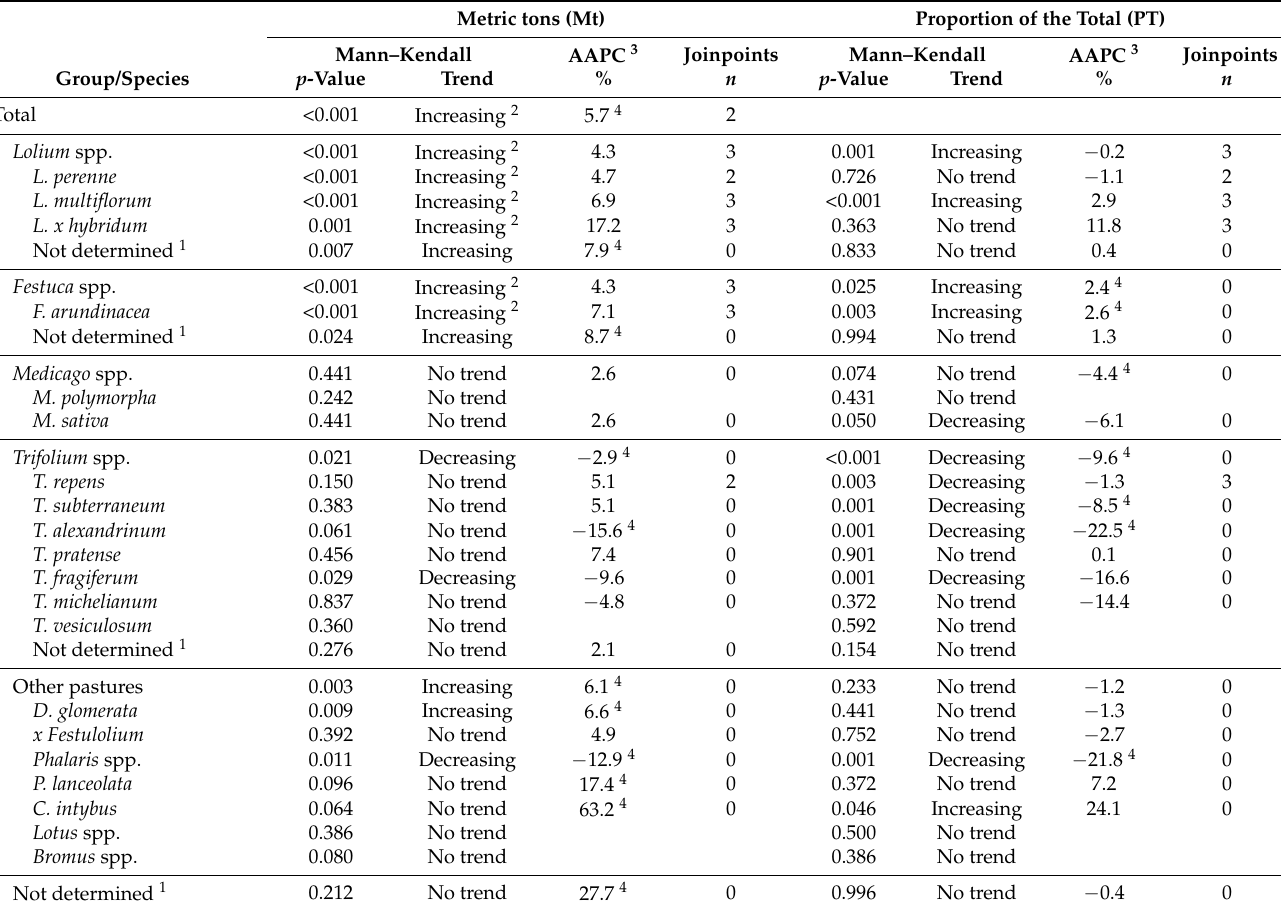
Table 2. Trends (Mann–Kendall) and joinpoints (AAPC and number) of imported seed from 2001 to 2019.